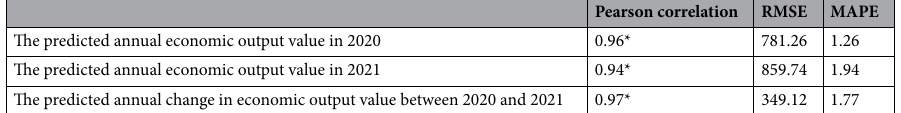
Pearson correlation RMSE